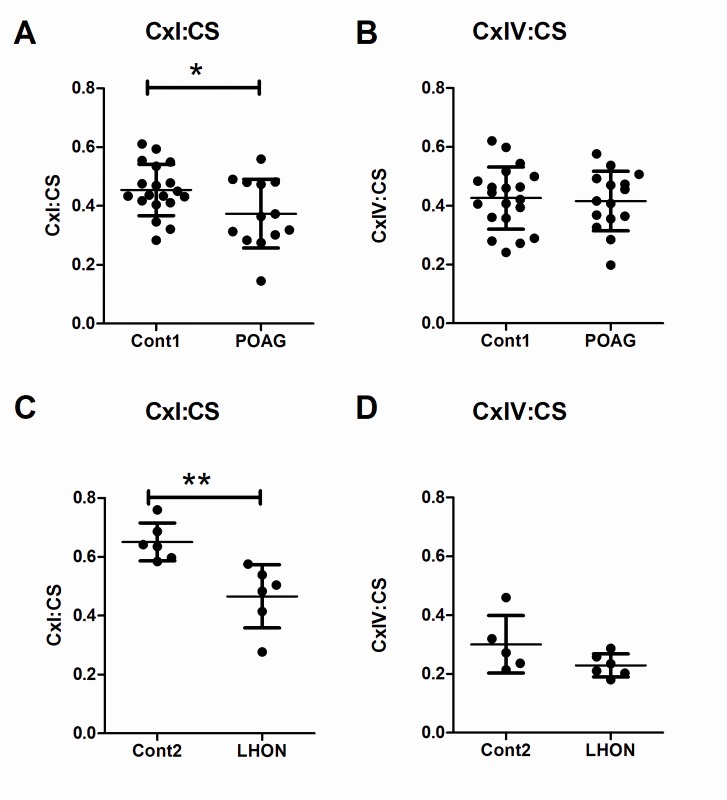
Impaired OXPHOS complex-I in POAG and LHON lymphoblasts.There was a significant decrease in complex-I specific activity in A) POAG and C) LHON lymphoblasts when specific activities were ratioed to that of the Kreb’s cycle enzyme citrate synthase. There was no change in the specific activity of Complex-IV for B) POAG or D) LHON lymphoblasts when ratioed to citrate synthase. Data is mean ± SD, students t-test, n = 20 cont1, n = 15 POAG, n = 6 cont2 and n = 6 LHON, * = p< 0.05, ** = p< 0.01.